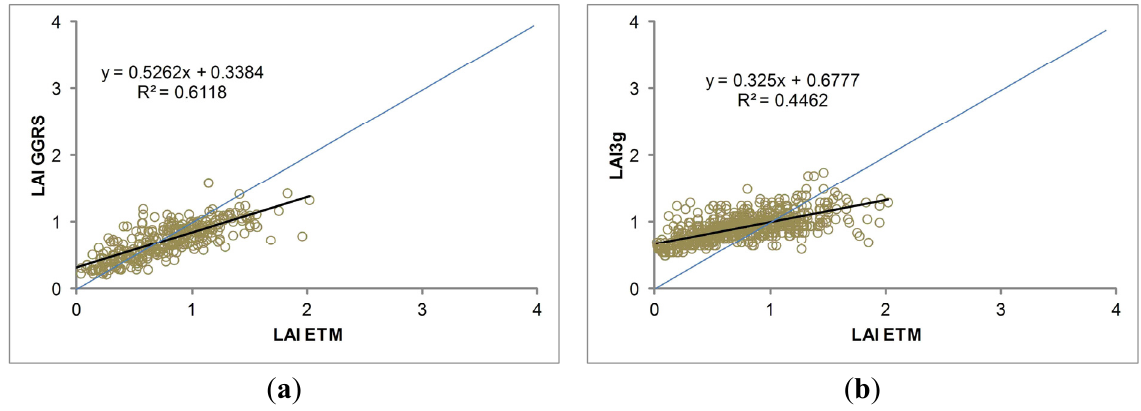
Figure 2. Validation of LAI products over grassland in the Shetsky test region for June 2008. Pixel-by-pixel ( n = 720) comparison of the aggregated fine-resolution Landsat-derived LAI map versus the LAI GGRS product ( a ); and versus the LAI3g product ( b ).